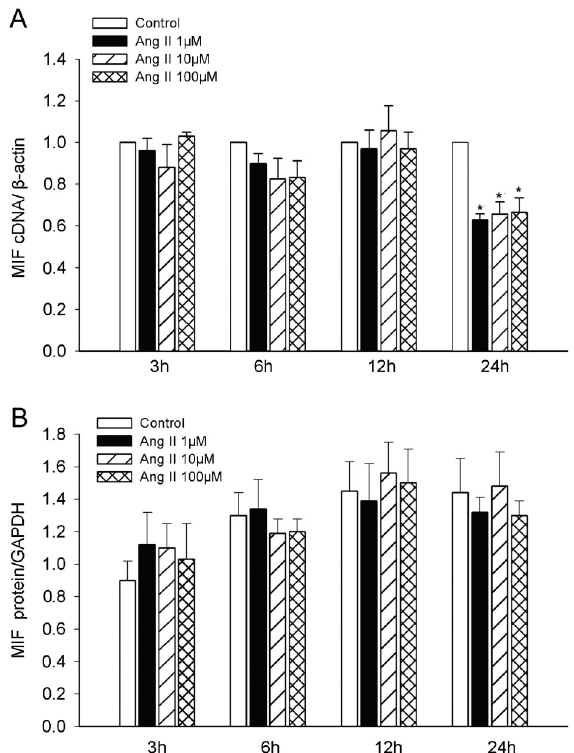
Figure 3. Effects of angiotensin II (Ang II) on the migration inhibitory factor (MIF) expression of HL-1 cells. HL-1 cells were stimulated by Ang II (1, 10, 100 m M) for the indicated periods. Levels of MIF mRNA and protein were analyzed using Western blotting or real-time PCR with b -actin ( A ) or GAPDH ( B ) as internal controls, respectively. Data are reported as means±SE of MIF expression for 4 independent experiments in duplicate. *P , 0.05 vs control (one-way ANOVA).